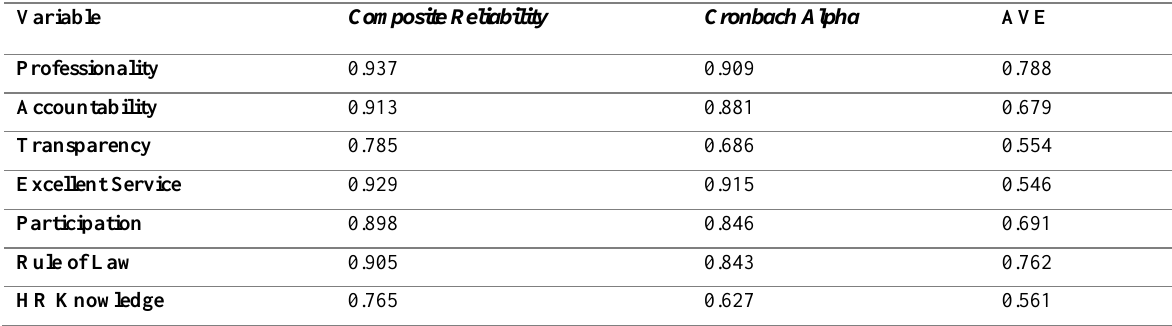
Table 5: Construct Reliability Test